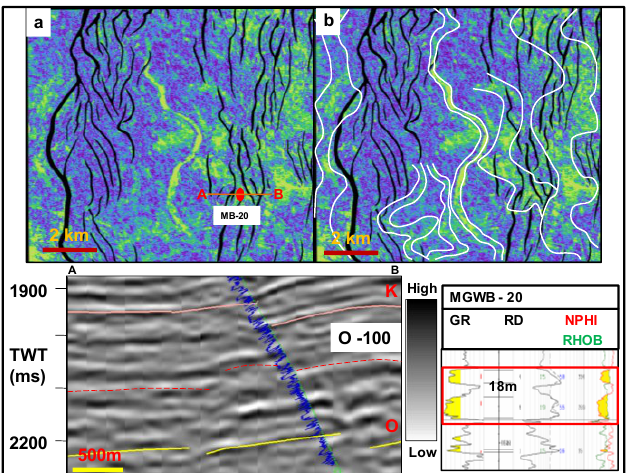
Figure 9: Spectral decomposition 20 Hz frequency slice (a).The interpretation shows various meander belts with superimposed pattern (b). The seismic section along A-B shows strong amplitude at the sand position confirmed by log data. Red ellipse indicates well location. The width of the meander belt is in the range of 1.5 to 3 km which is analogous to the ones found in period 1. The width of abandoned channels identified from dip steered similarity map is around 120 - 330 m. Another interesting feature is the presence of sand filled channel (Figure 10) in period 3.